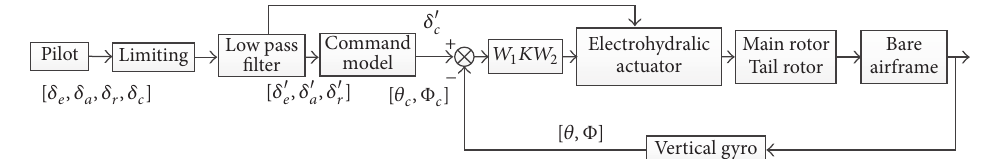
Figure 4: Implementation of ACAH mode into Bell 205’s 𝐻 ∞ control